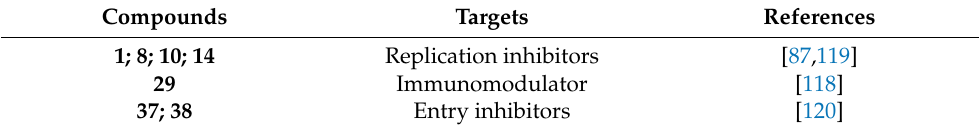
Table 10. Summary of anti-EV71 triterpenoids and their targets and activities.